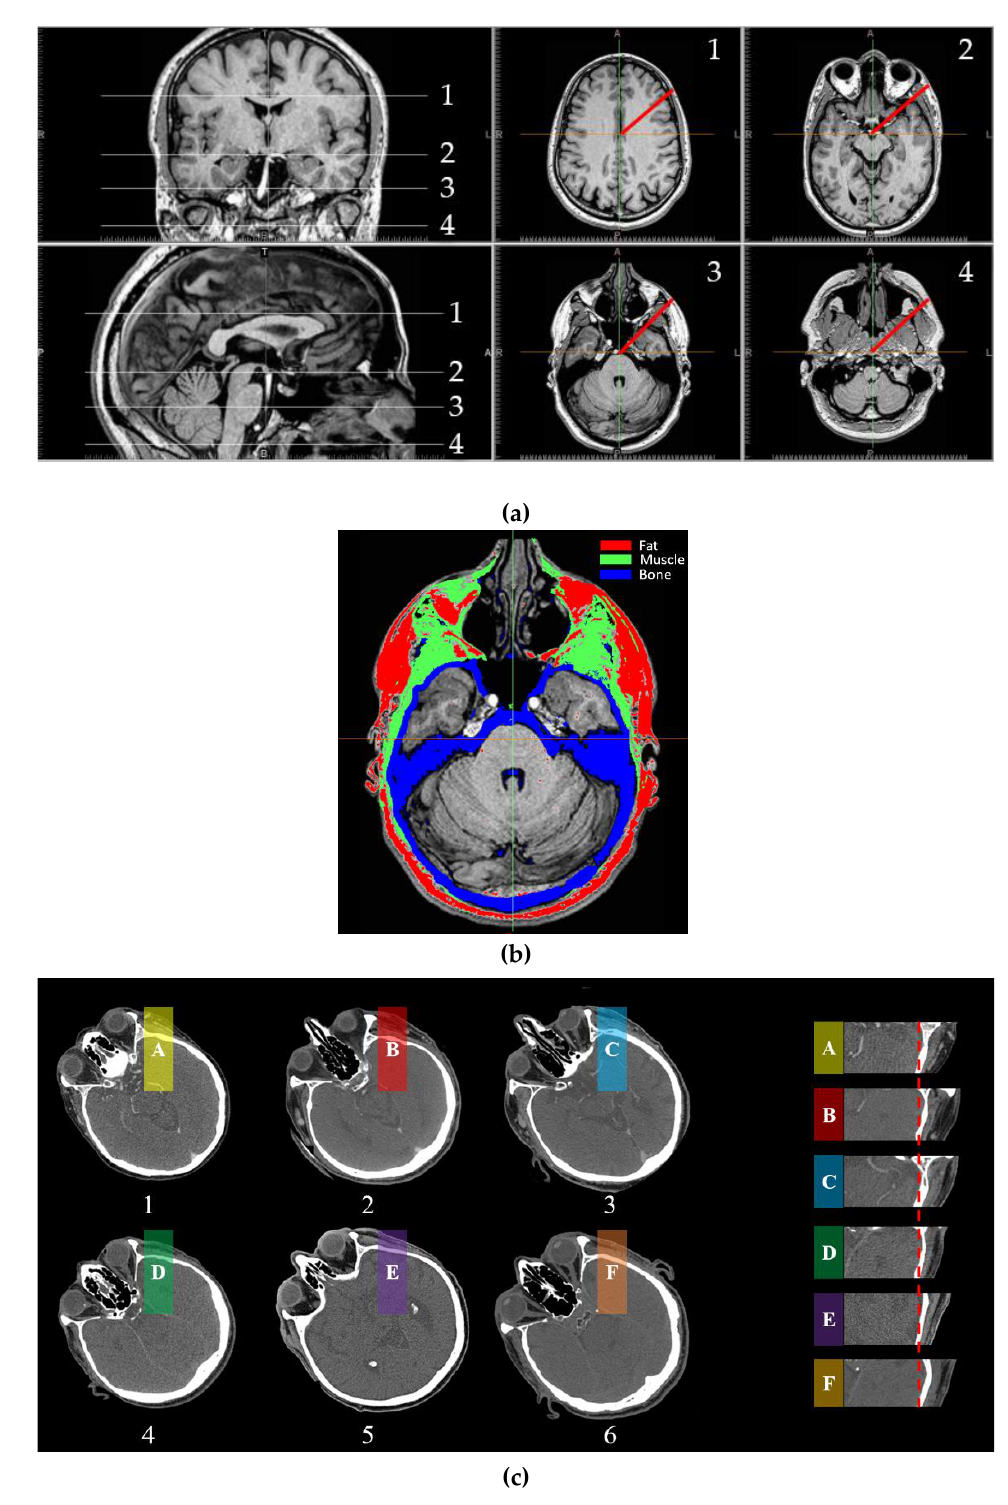
Figure 2. The structures of different sections of the head obtained by MRI. In ( a ), the two left images are the front and side view of the head. Sub images of 1, 2, 3, and 4 on the right side show the different sections from the top to bottom of the head. The image ( b ) shows the mask results of different tissues of section ( 3 ). The image ( c ) shows the comparison of tissue thickness between different individuals at the same section of the head.